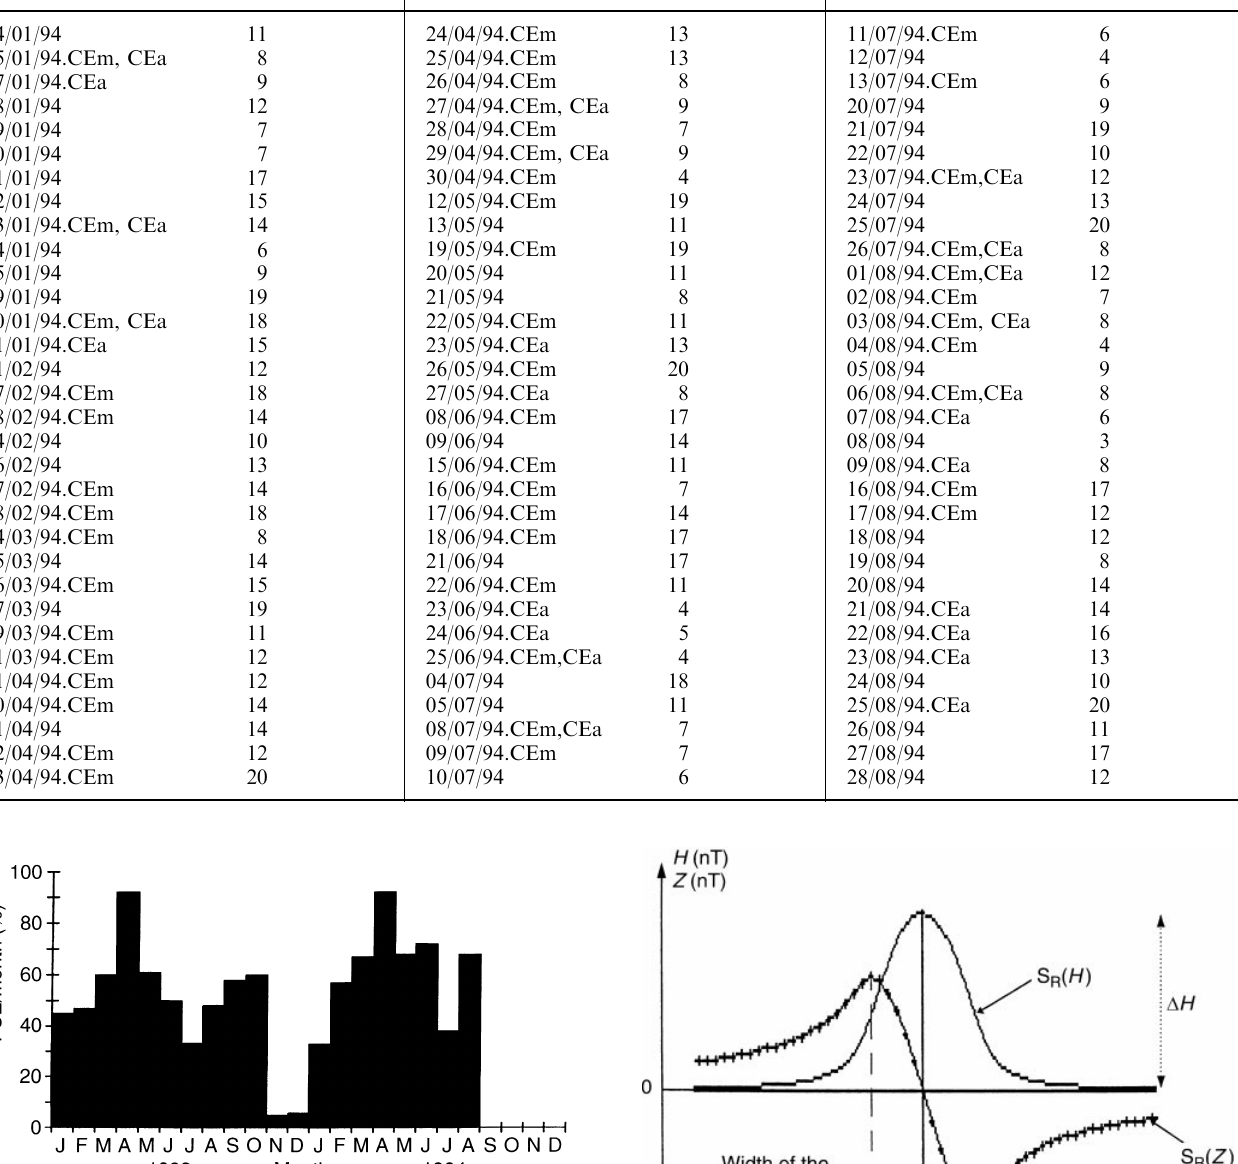
Table 3. Daily means of the magnetic activity indices ( Am ) for selected days in 1994. Counter-electrojet days are indicated by CEm for morning counter-electrojet and CEa for afternoon counter electrojet quiet days